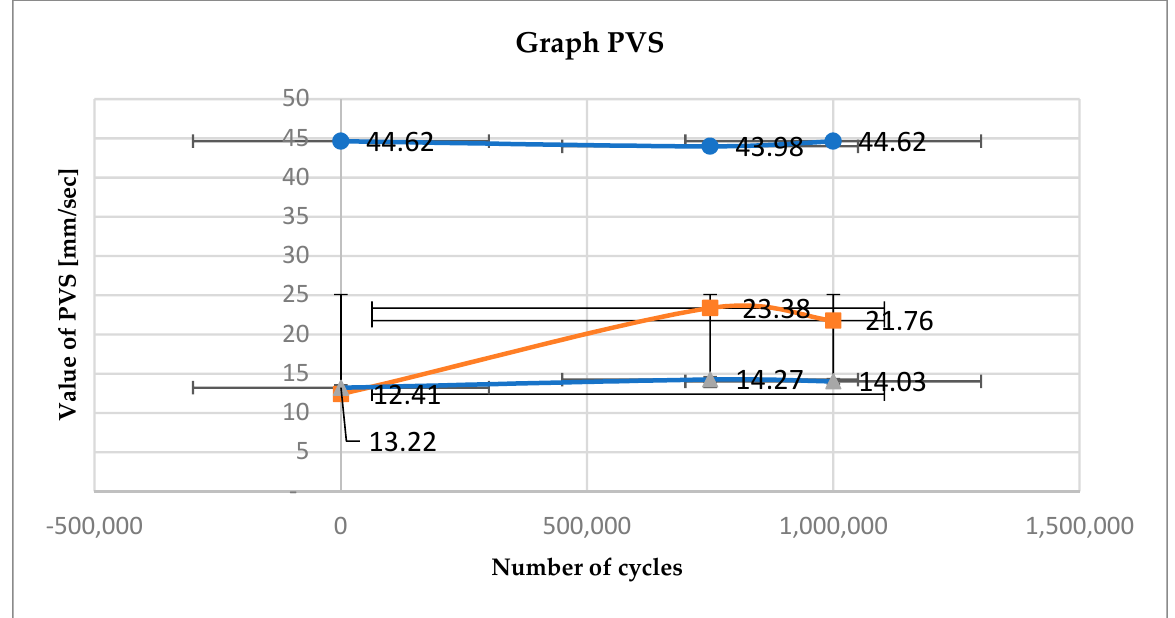
Figure 11. Plot of the calculated PPV values under cyclic low-frequency pulsed loading for the geophone locations shown in Figure 9.